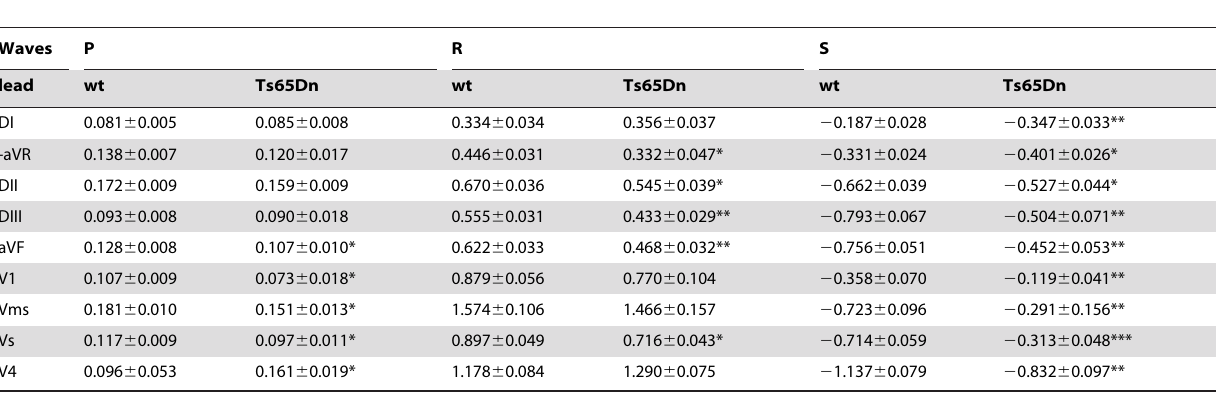
Table 3. P, R, and S wave amplitudes (mV) of wt and Ts65Dn mice (n=18) for superior leads (DI and aVR), inferior leads (DII, DIII, and aVF), and precordial leads (V1, Vms, Vs, and V4).